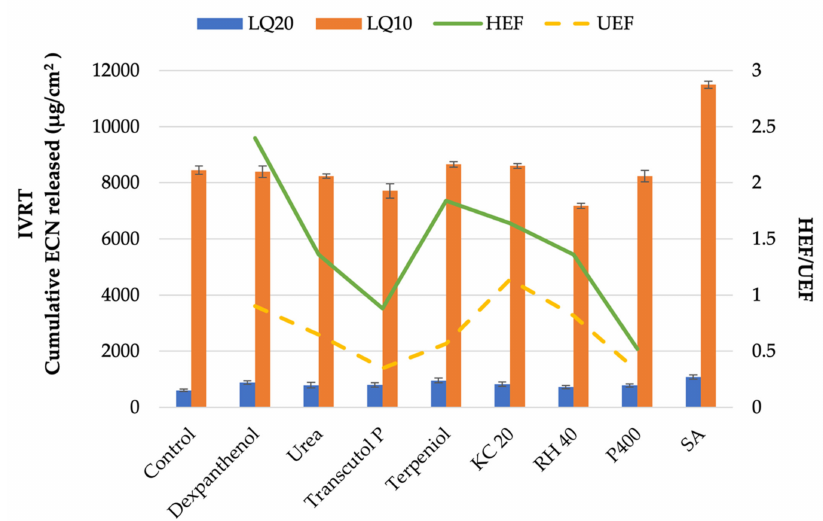
Figure 1. Comparative analysis of lacquers containing 10% w / w polymer (LQ10) and 20 % w / w poly- mer (LQ20) with different permeation enhancers, showing cumulative amount of econazole nitrate released on the primary Y-axis, and hydration efficiency factor (HEF) and drug uptake enhancement factor (UEF) on the secondary Y-axis. The bars represent the cumulative drug release from in vitro release tests (IVRT), solid and broken lines represent the HEF and UEF values, respectively.